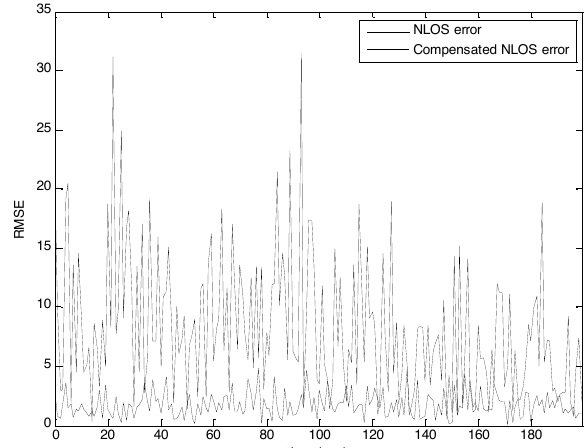
Figure 1: RMSE comparison between compensated result and uncompensated